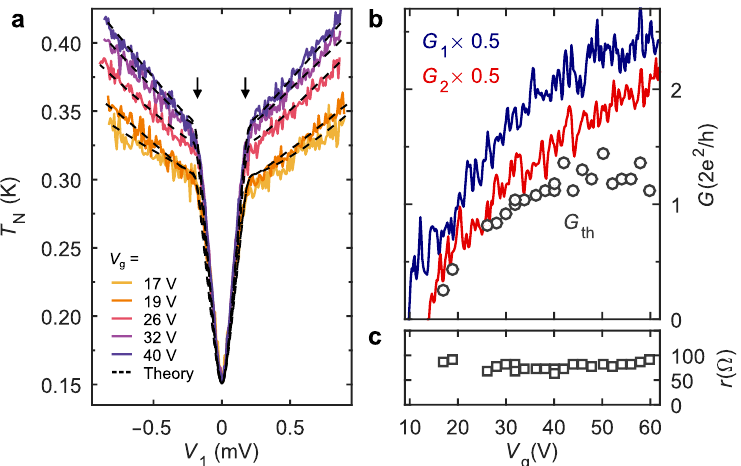
Figure 3. Thermal conductance in the device NSN-I. ( a ) Noise temperature T N measured in the transmission configuration as a function of bias (solid lines, same data as in the lower part of Figure 2b) along with the model fits (dashed lines). ( b , c ) (symbols) Sub-gap thermal conductance G th and interface resistance parameter r plotted as a function of V g . (lines) Linear response conductances of the left/right ( G 1/2 ) NS